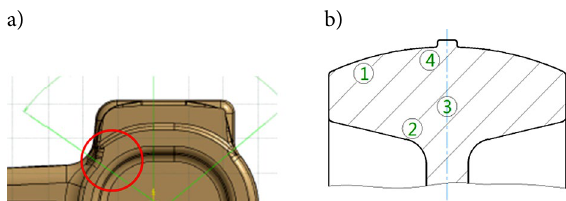
Fig. 4. Areas for micro and macro research at cross-cut of forging: a – location for the samples preparing; b – places at the plane of cross-cut for the research of structure